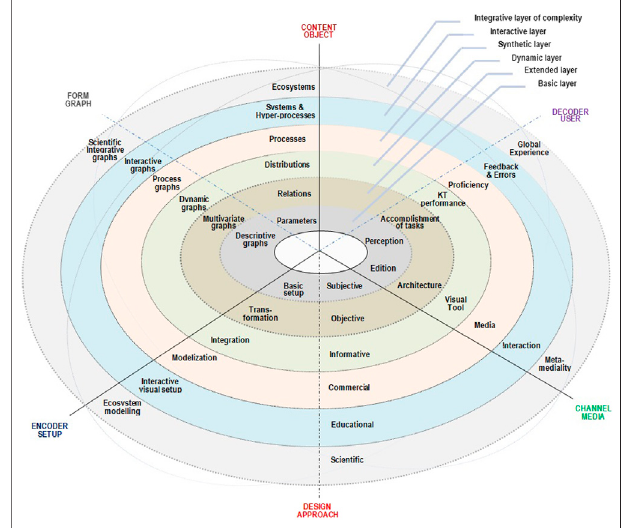
FIGURE 7 | Illustrative representation of the dimensional taxonomy for object-oriented data visualization from the perspective of communication sciences: elements-axes as factors of completeness and layers spheres as factors of complexity. Source: Own